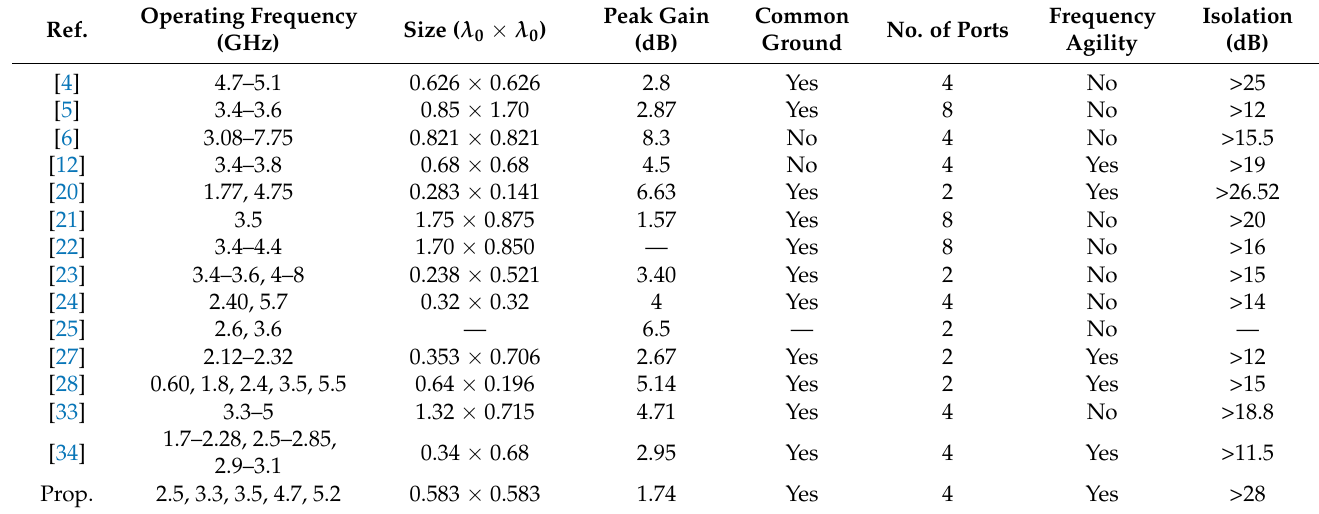
Table 3. Comparison of the developed frequency agile MIMO antenna and existing MIMO antennas.